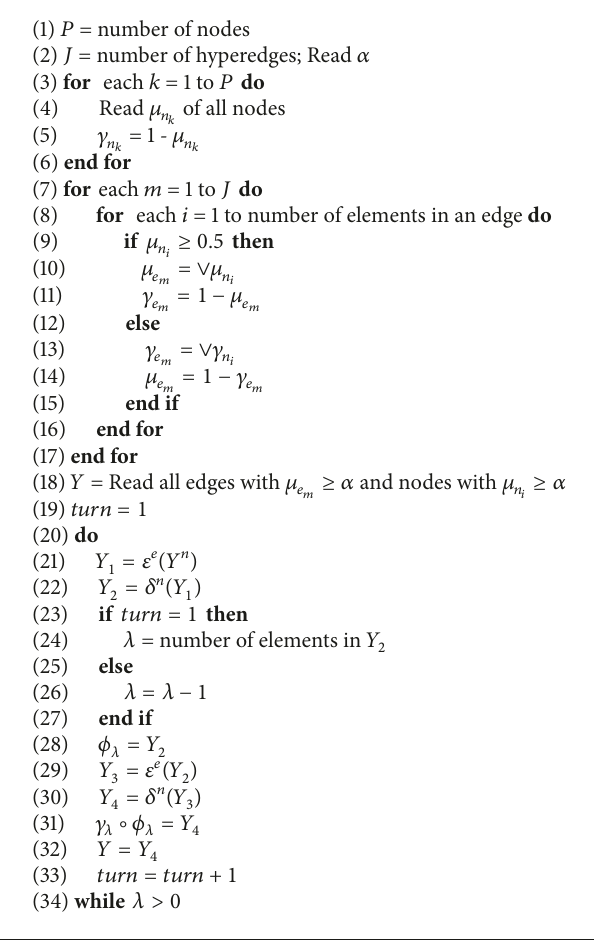
Algorithm 1: Metric induced alternate sequential filtering of IFHG.